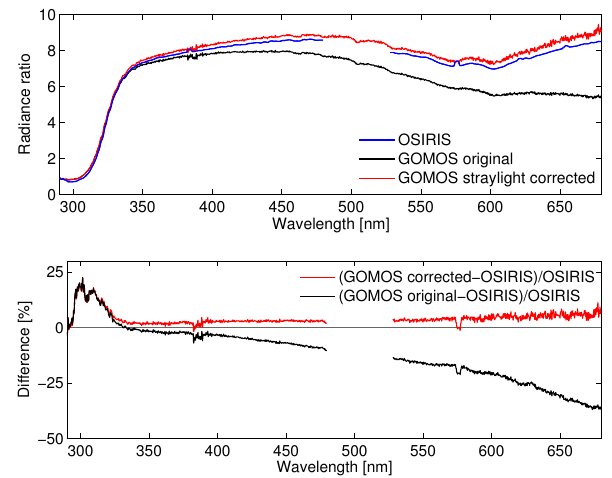
Fig. 7. Example of radiance ratios from GOMOS and OSIRIS. Up- per panel: ratios of 30 and 47km. Lower panel: relative